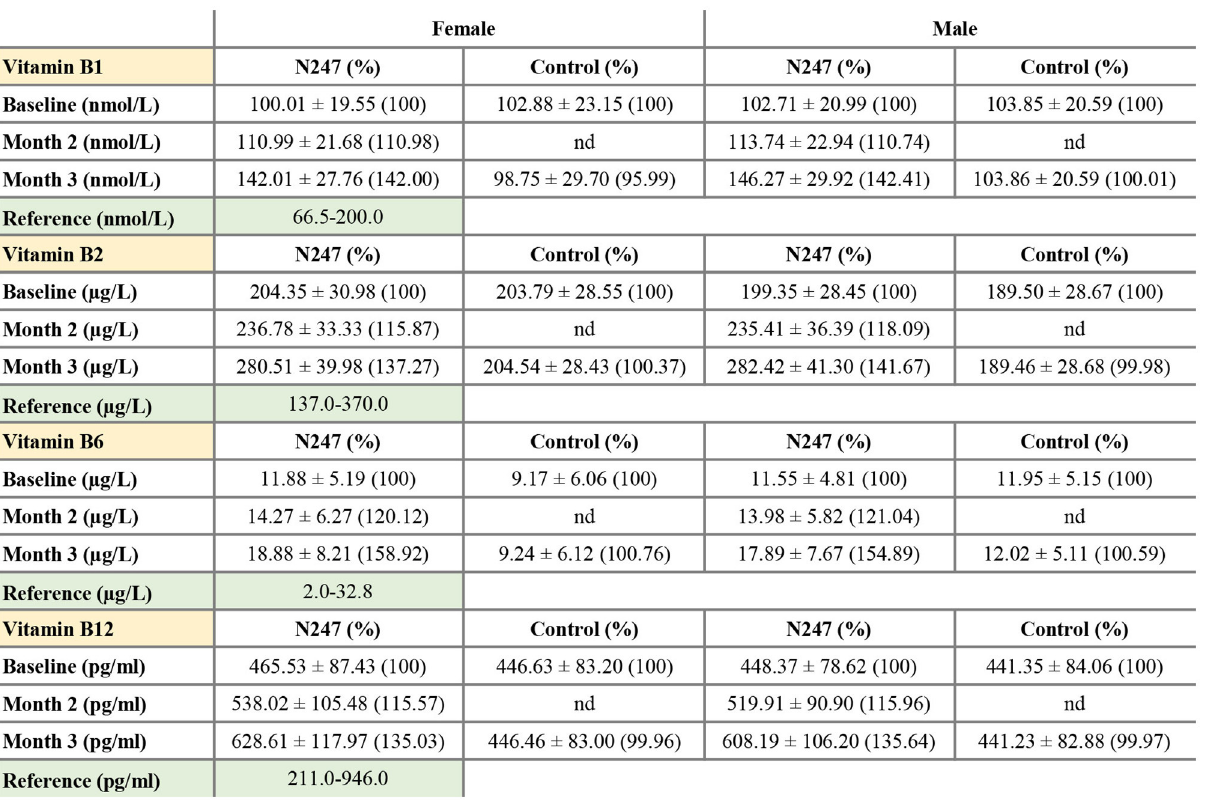
FIGURE 5 | Serum concentrations of vitamin B1, B2, B6, and B12. Values are mean